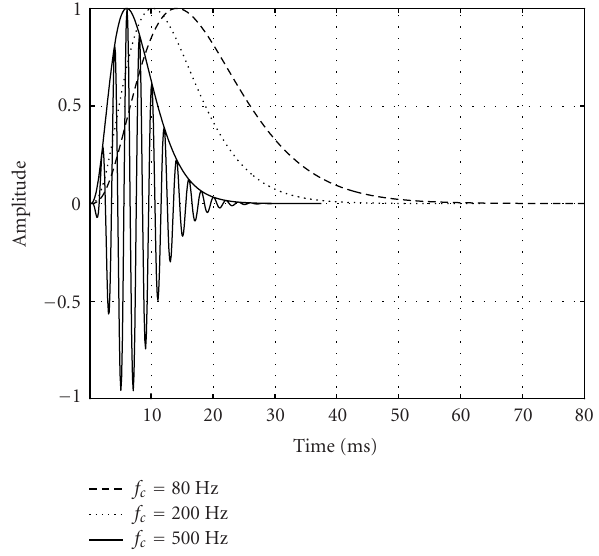
Figure 4: Impulse response and impulse response envelopes of gammatone filters for di ff erent center